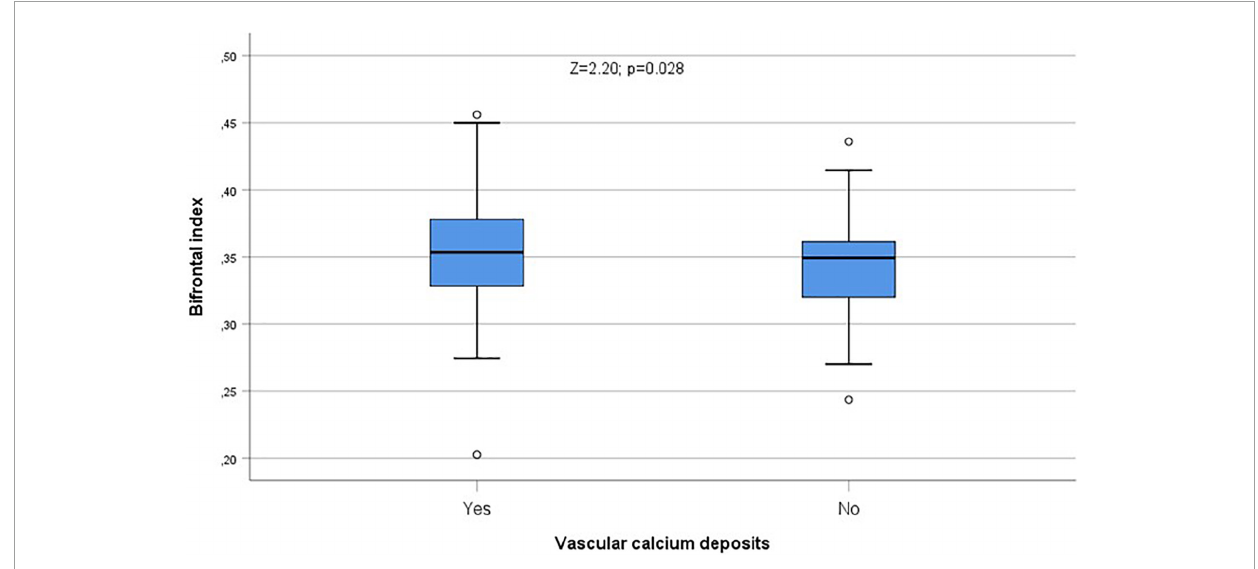
FIGURE8 Calcium deposits were significantly related to Bifrontal index ( Z = 2.20; p = 0.028). ◦ Represent the outliers and *represent the extreme